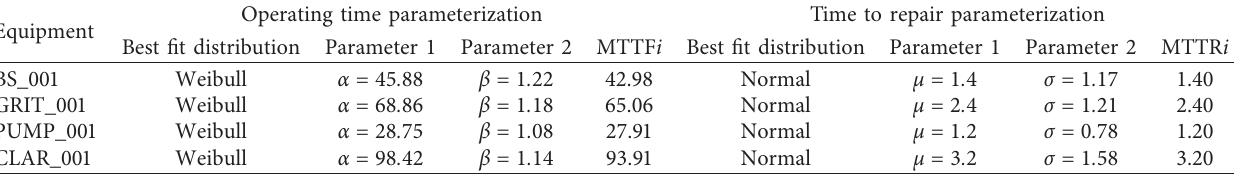
Table 3: Reliability and maintainability information. Operating time parameterization Time to repair Equipment